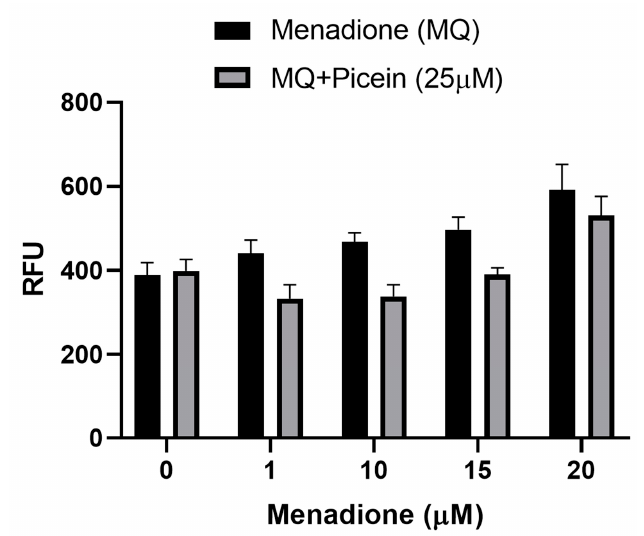
Figure 6. Level of mitochondrial superoxide in human SH-SY5Y neuroblastoma cells were measured after menadione (MQ) treatment and follow-up treatment with picein. The data are presented as mean ± SEM. To give evidence for the statistical variations, factorial ANOVA was applied to examine the p -values for each factor, where three experiments with three samples per group were considered. Statistically significant di ff erences were examined for picein ( p < 0.0001), and MQ ( p < 0.0001). RFU indicates relative fluorescence units. Antioxidants 2020 , 9 , x FOR PEER REVIEW